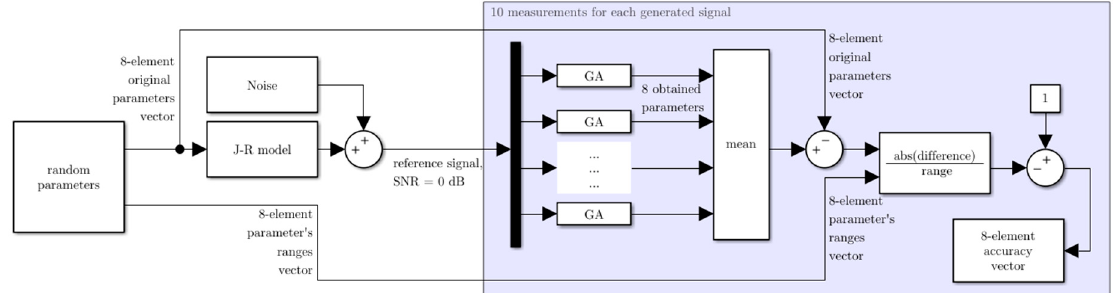
Figure 4. Visualization of the accuracy study. Note, that this process was conducted 100 times, with different reference parameters.